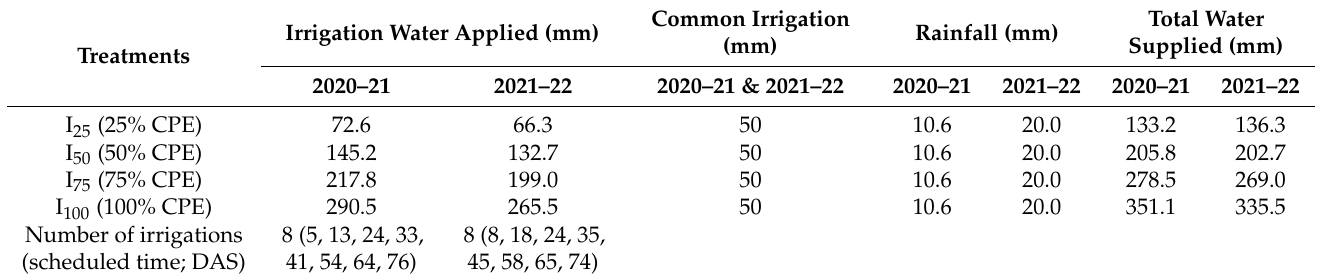
Table 5. Total amount of water supplied during crop-growing period (2020–21 and